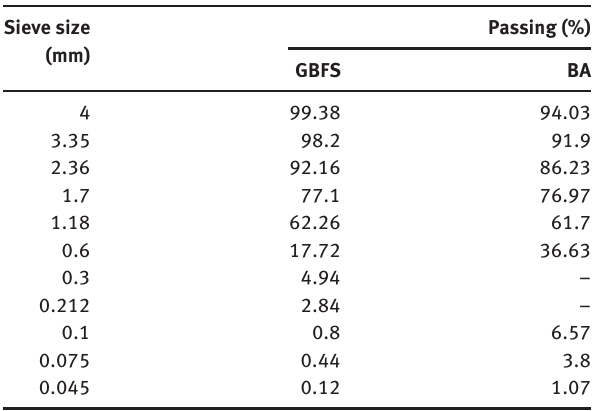
Table 4: Size distributions of GBFS and BA.